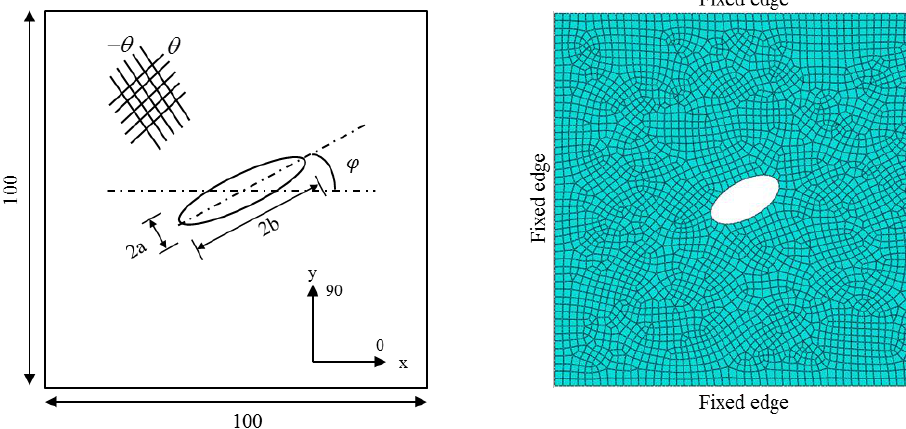
Figure 1: Geometric modeling and meshing of the plate with elliptical hole.